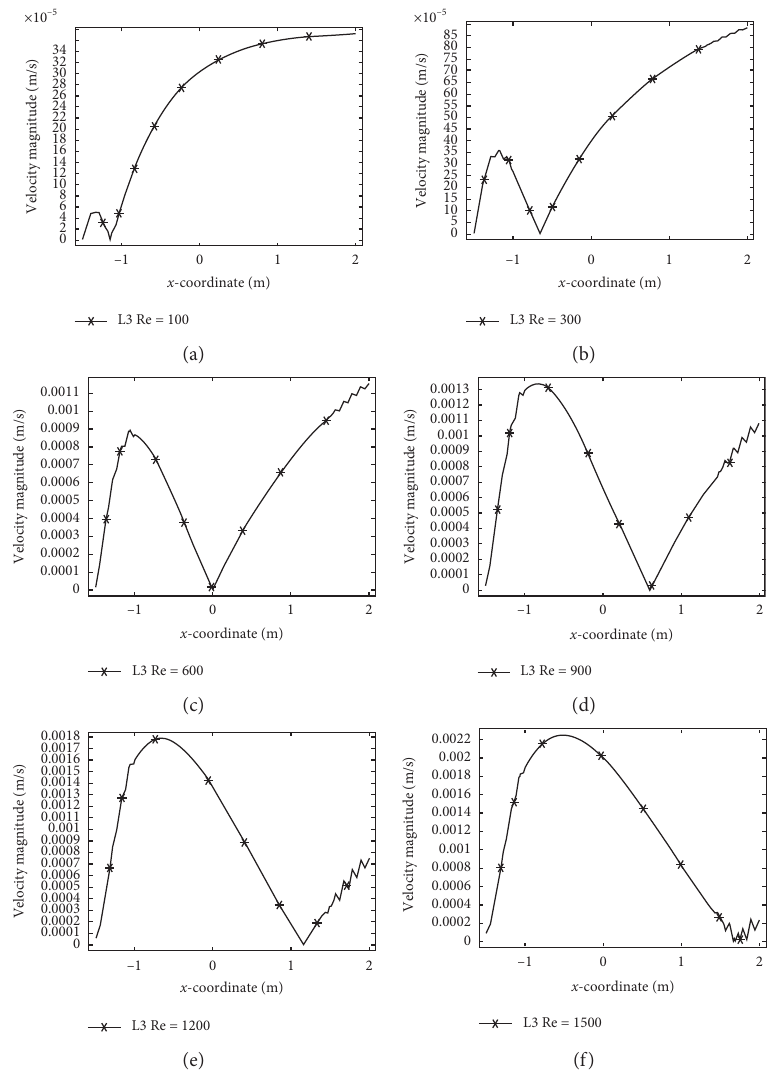
Figure 7: Orientation of the velocity field in Lines L3.